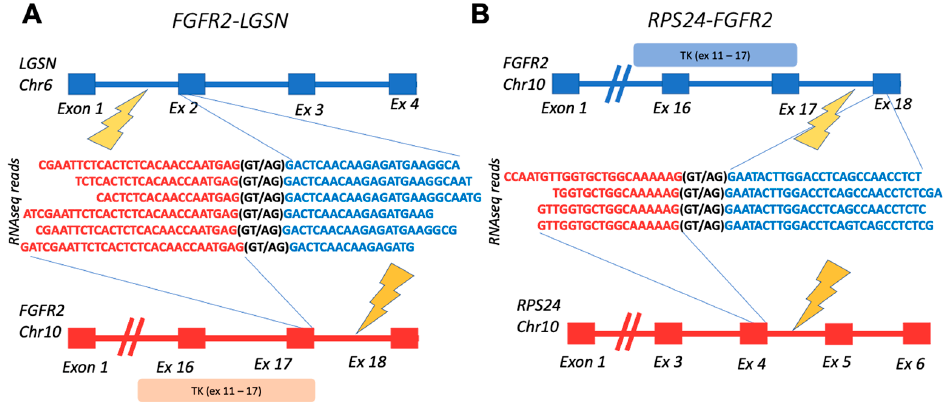
Figure 3. Schematic representation of fusion transcripts identified in OC11 sample: ( A ) gene struc- tures upstream and downstream of FGFR2-LGSN fusion site; ( B ) gene structures upstream and downstream of RPS24-FGFR2 fusion site. TK, FGFR2 -encoded tyrosine kinase domain.